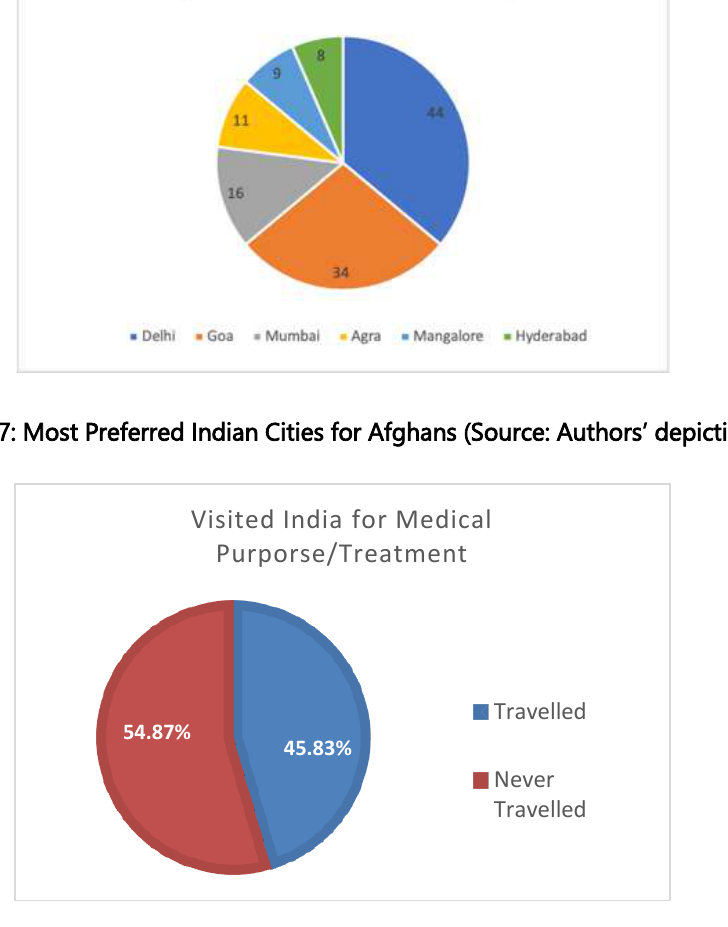
Figure 8: Have you or anyone in your family visited India for medical treatment? ( Source: Authors‟ depiction ) Table 9: How was your experience of medical services in India? ( Source: Authors‟ depiction